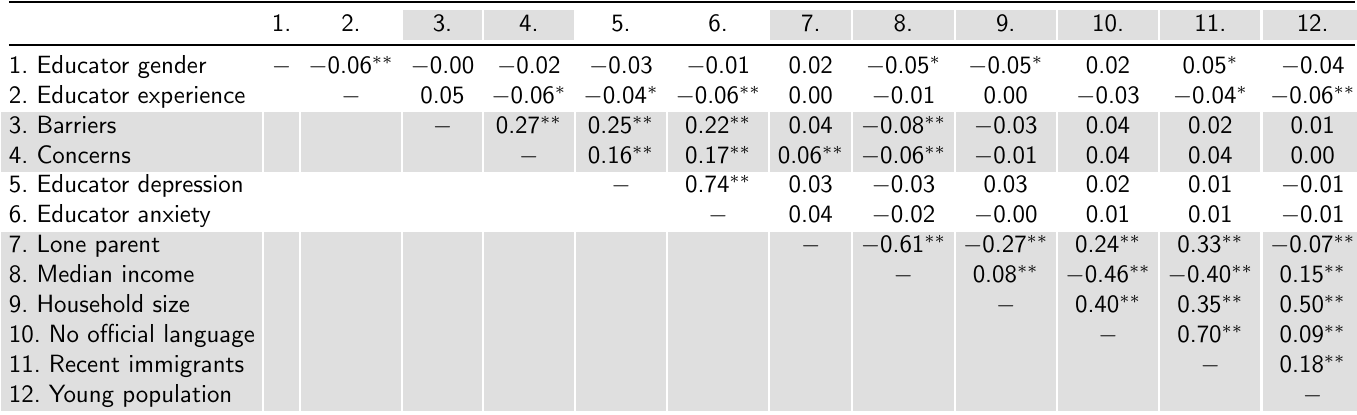
Table 6: Results of a Poisson regression analysis examining the association between neighbourhood median income and barriers to distance learning ( n = 1 , 128)